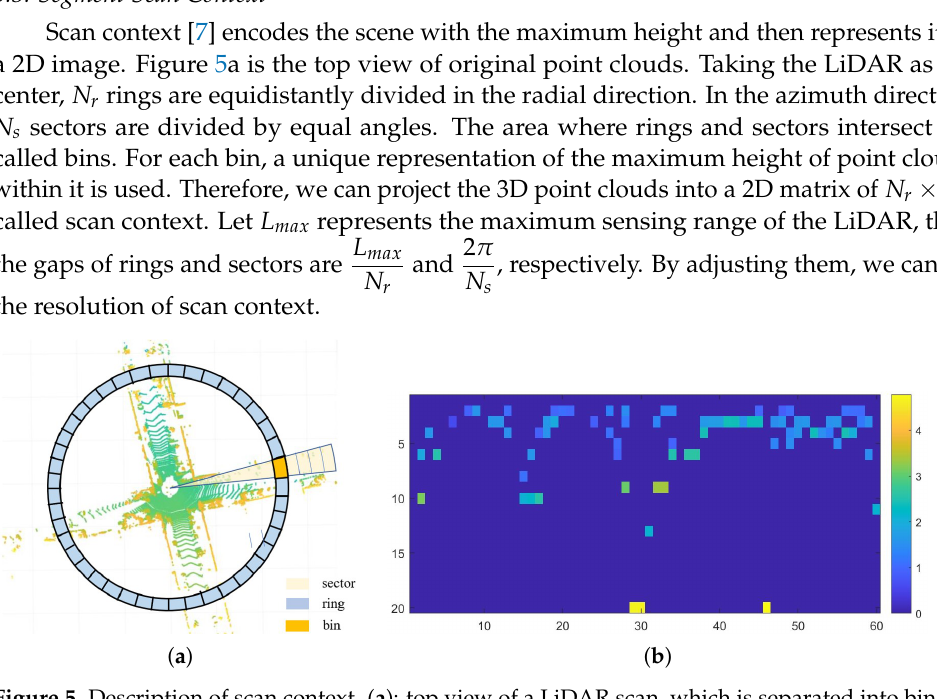
Figure 5. Description of scan context. ( a ): top view of a LiDAR scan, which is separated into bins by rings and sectors. ( b ): colormap of our segment scan